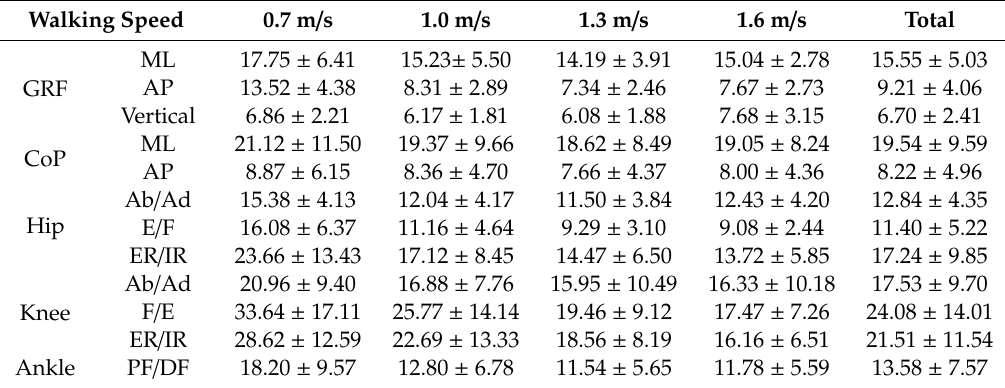
Table 3. NRMSE of GRF, CoP, and joint torques (%) at each walking speed. Walking